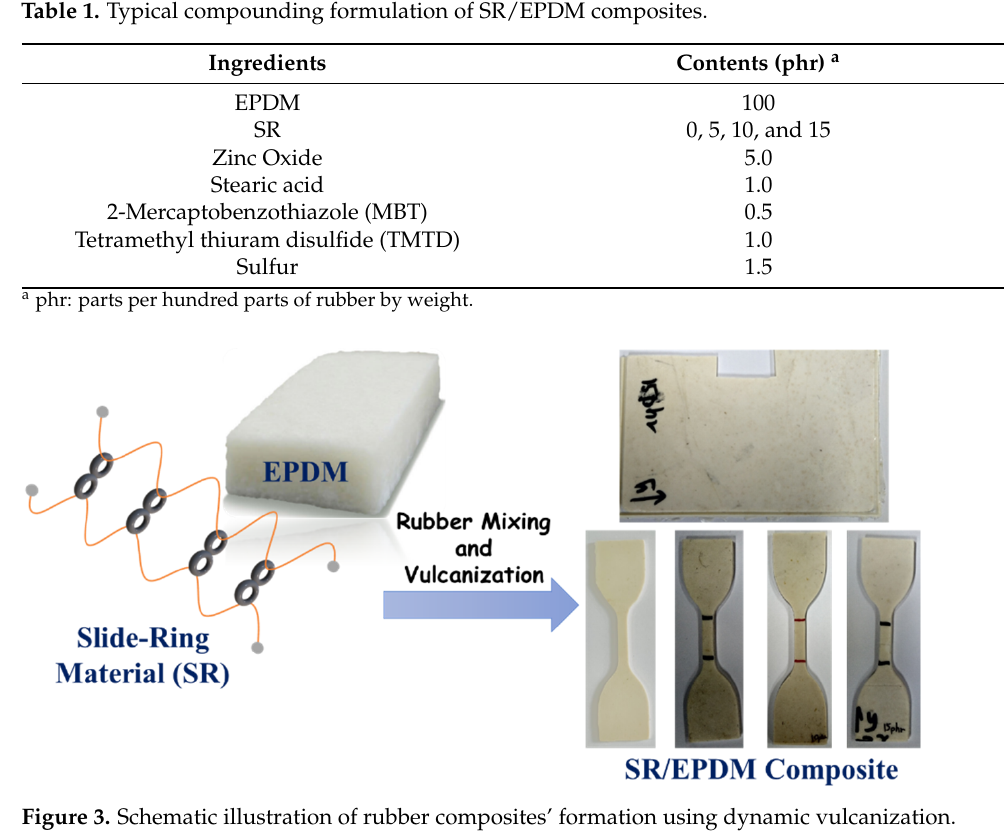
Figure 3. Schematic illustration of rubber composites’ formation using dynamic vulcanization.